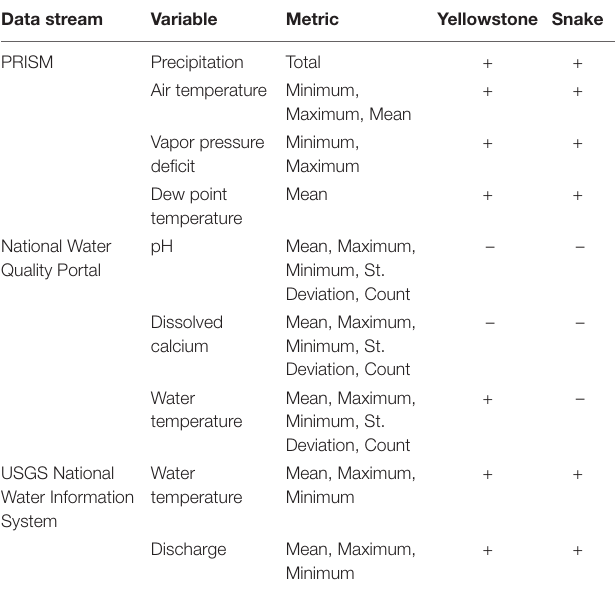
TABLE 1 | Physical data available at daily time steps that were collated on a cloud-hosted database and then integrated with raw eDNA data in multi-scale occupancy